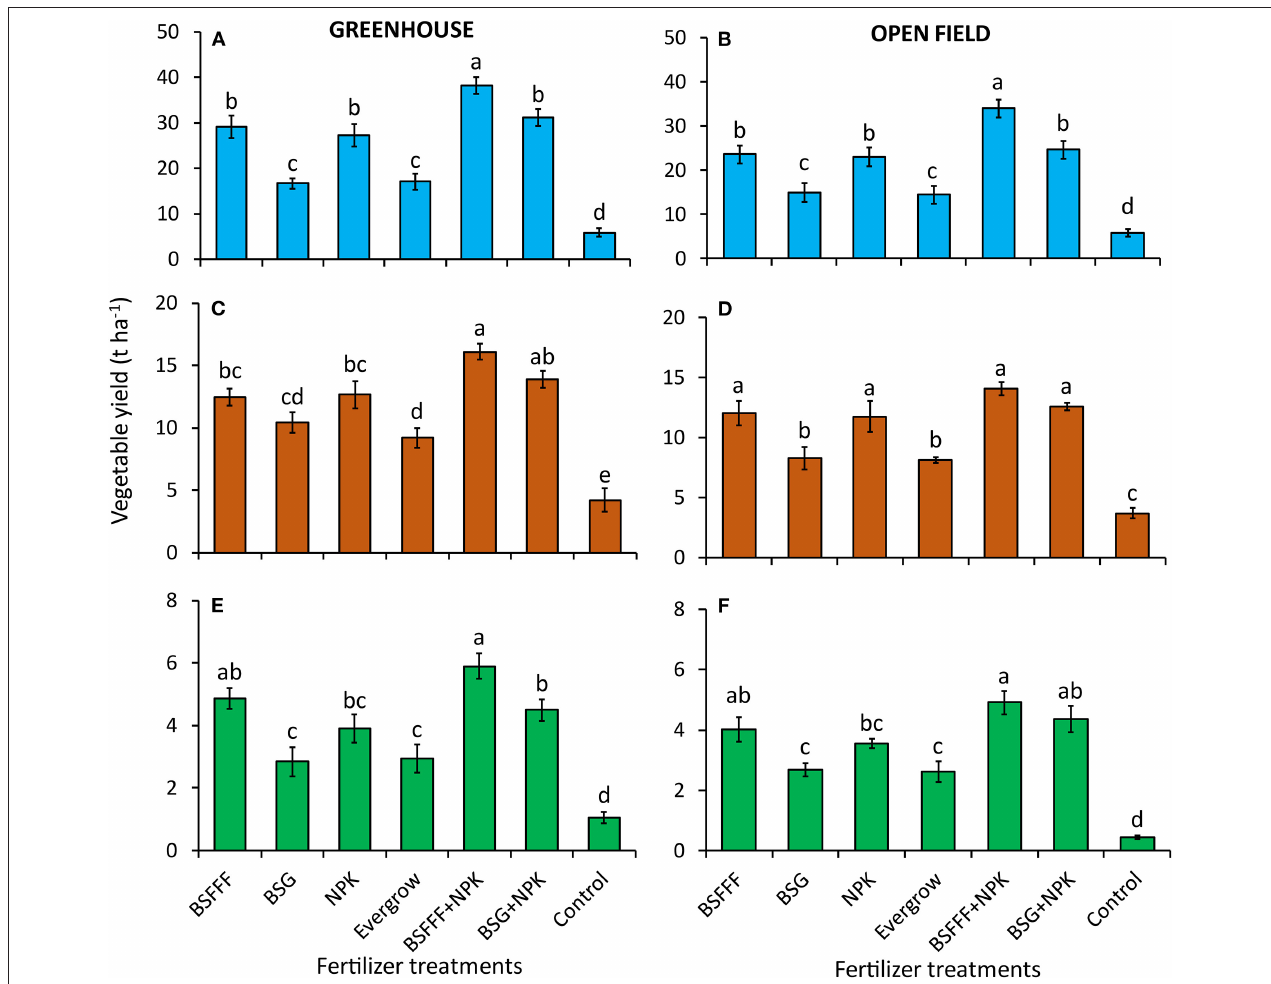
FIGURE 1 | Effect of composted BSF frass fertilizer, conventionally composted BSG, and commercial organic and inorganic fertilizer on the yield of tomatoes (A,B) , kales (C,D) , and French beans (E,F) under greenhouse (A,C,E) and open-field (B,D,F) conditions. BSFFF, black soldier fly frass organic fertilizer applied at sole rate equivalent to 371kg N ha − 1 ; BSG, conventional compost from brewer’s spent grain applied at sole rate equivalent to 371kg N ha − 1 ; NPK, commercial mineral fertilizer applied at sole rate equivalent to 371kg N ha − 1 ; Evergrow, commercial organic fertilizer applied at sole rate equivalent to 371kg N ha − 1 ; BSFFF + NPK, combined application of BSFFF and NPK so that each supplies 185.5kg N ha − 1 ; BSG + NPK, combined BSG compost and NPK so that each supplies 185.5kg N ha − 1 , control, unfertilized soil. Per panel, means ( ± SE) followed by the same letters are not significantly different for α =